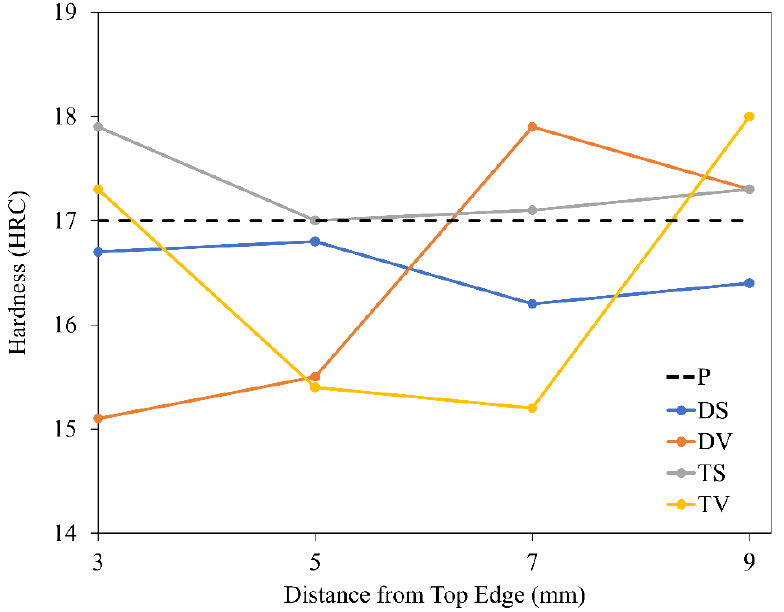
Figure 14. Hardness profile on the surface of the worn cutting edges in double ‐ edge and triple edges with spiral and V ‐ orientation shredder blades.